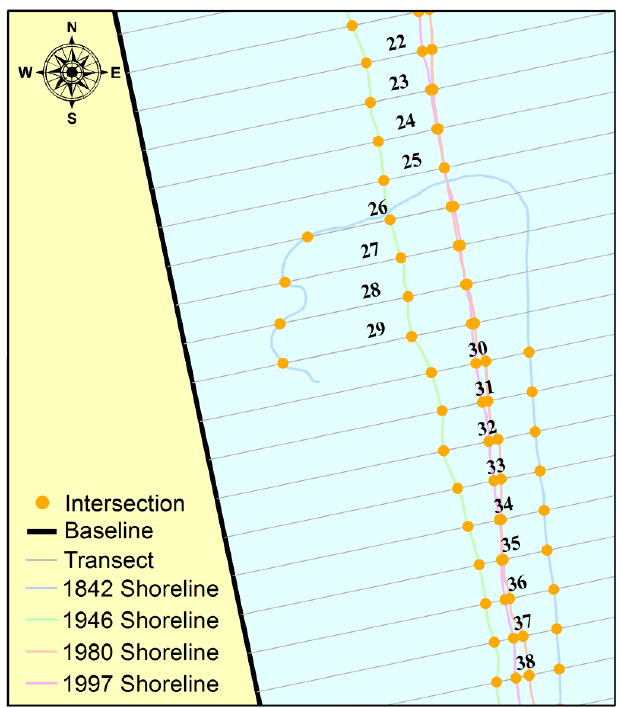
Figure 3. Schematic diagram of the Digital Shoreline Analysis System (DSAS). The sample data of the shoreline are provided by the DSAS software application.